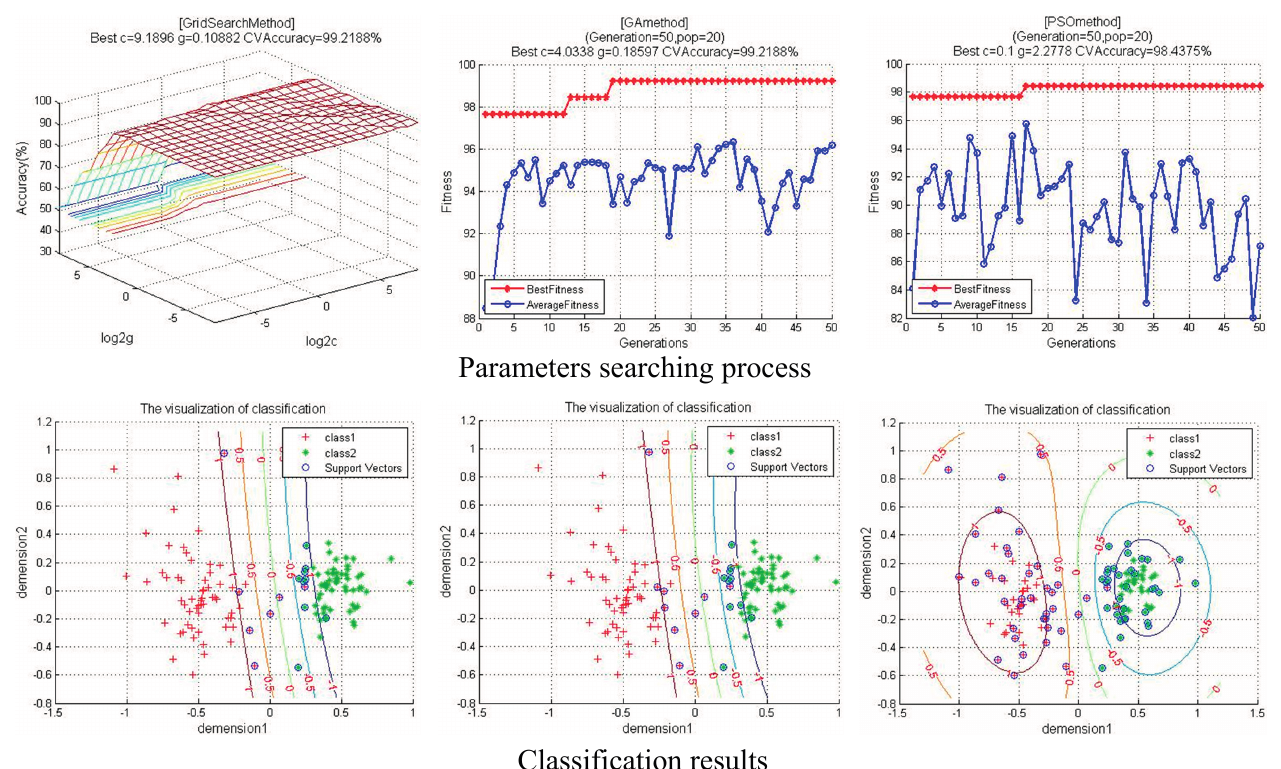
Figure 17. Parameter search with different optimization methods.